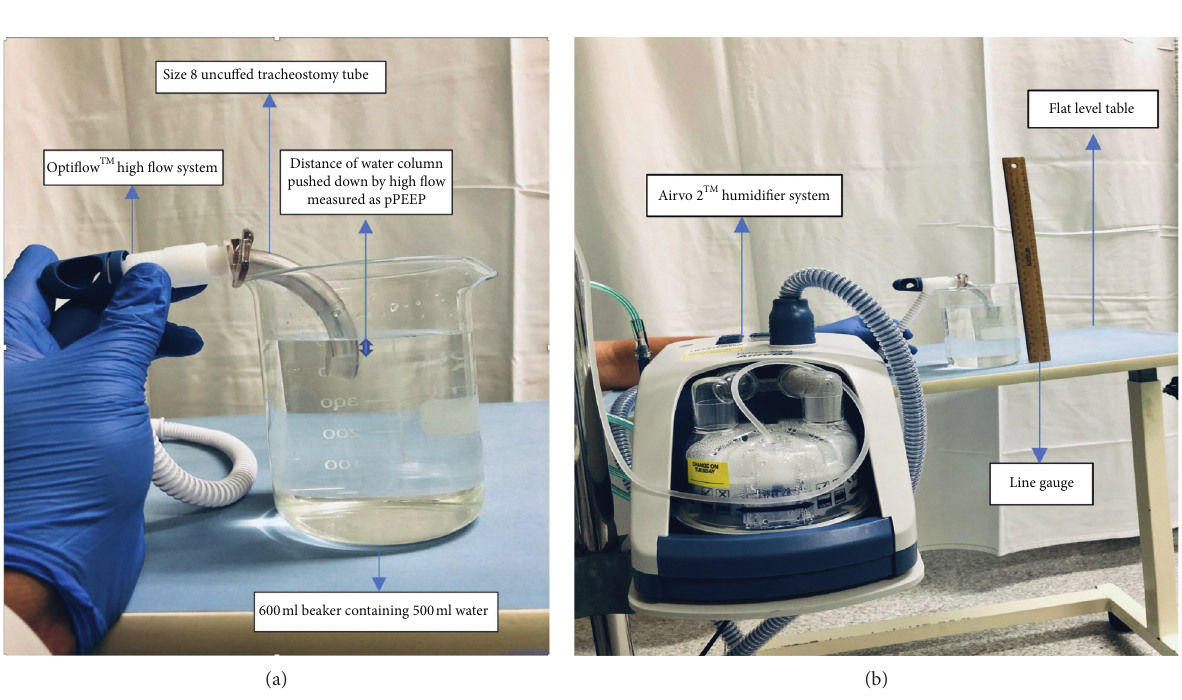
Figure 2: (a) Image of benchtop experiment setup. (b) Airflow ™ humidifier with Optiflow ™ high flow